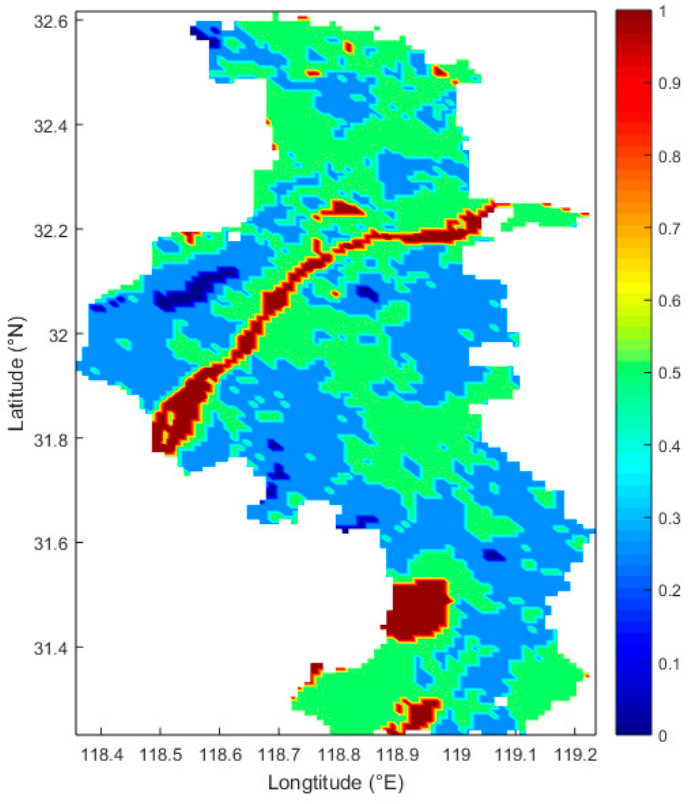
Figure 6. The 550 nm band AOD distribution for the Nanjing area during the haze